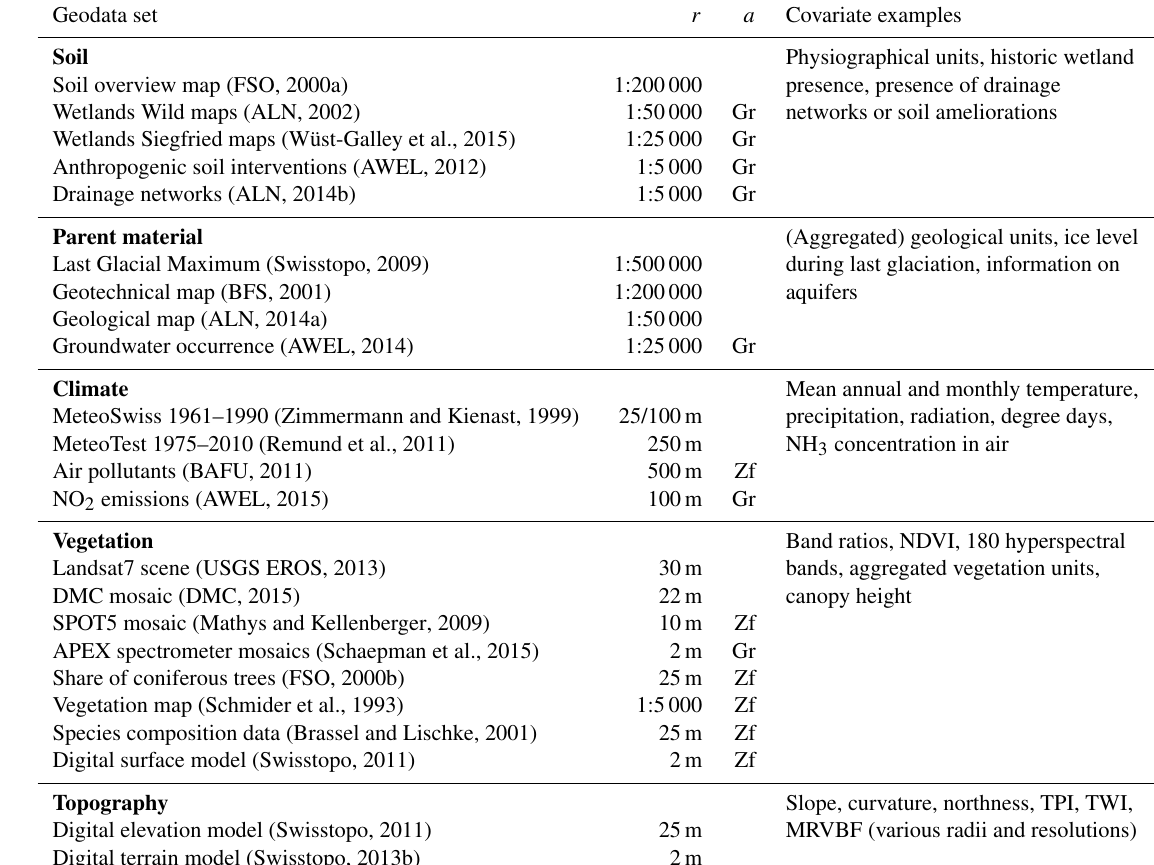
Table 1. Overview of geodata and derived covariates; for more information see the Supplement of Nussbaum et al. (2017); ( r : pixel resolution for raster datasets or scale for vector datasets, a : only available for study region Greifensee (Gr) or ZH forest (Zf), NDVI: normalised differenced vegetation index, TPI: topographic position index, TWI: topographic wetness index, MRVBF: multi-resolution valley bottom